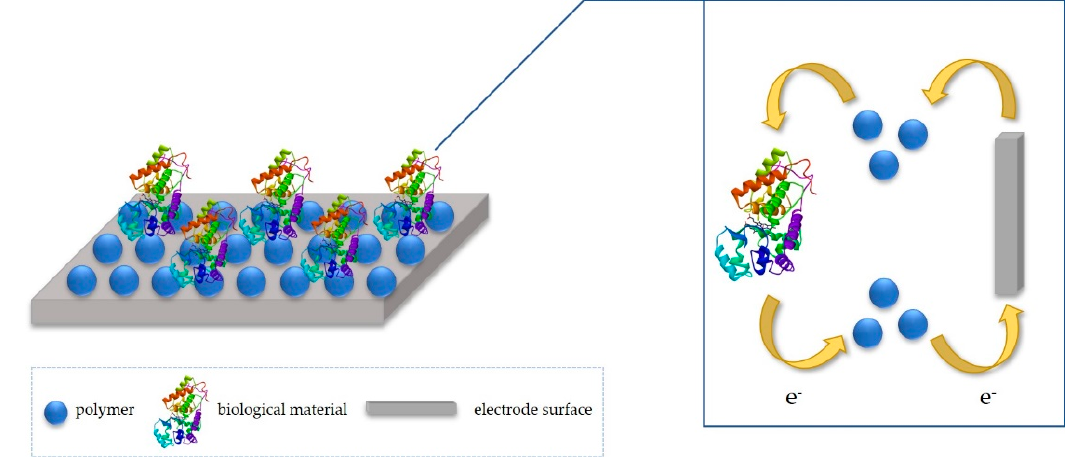
Figure 1. Mechanism of detection suing polymeric material.